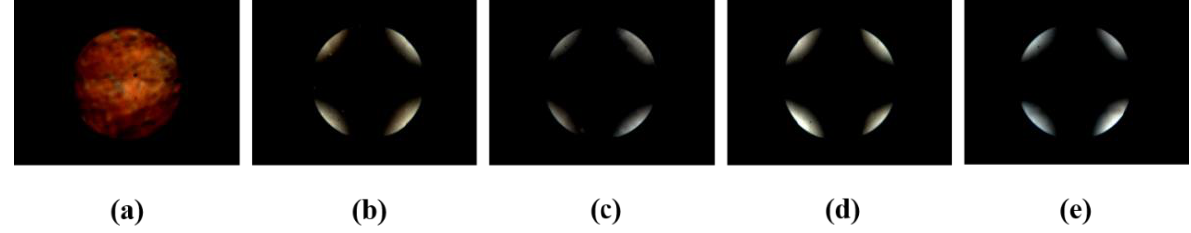
Figure 4. Conoscopic POM images of the LC cells fabricated with P4TB films under the following a weight ratio of the P4TB; ( a ) 0.001, ( b ) 0.01, ( c ) 0.05, ( d ) 0.1, and ( e ) 1.0 wt.%.